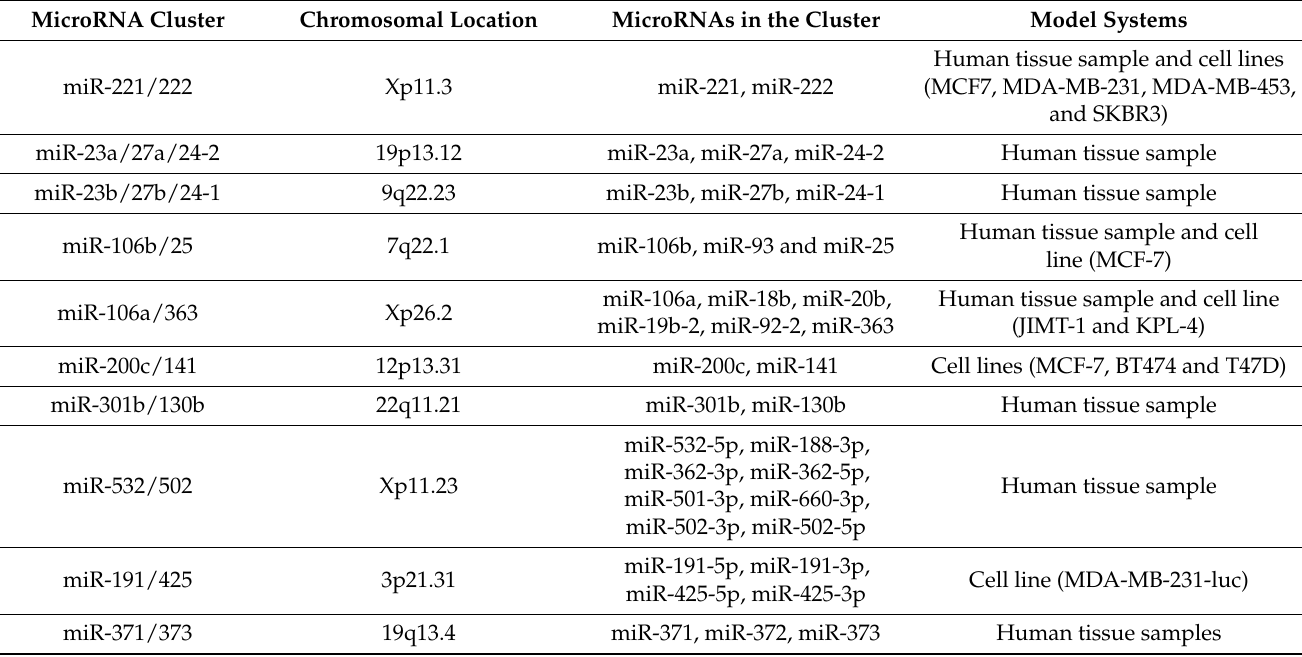
Table 1. Oncogenic MicroRNA Cluster, their Chromosomal location and members of MicroRNA Cluster.